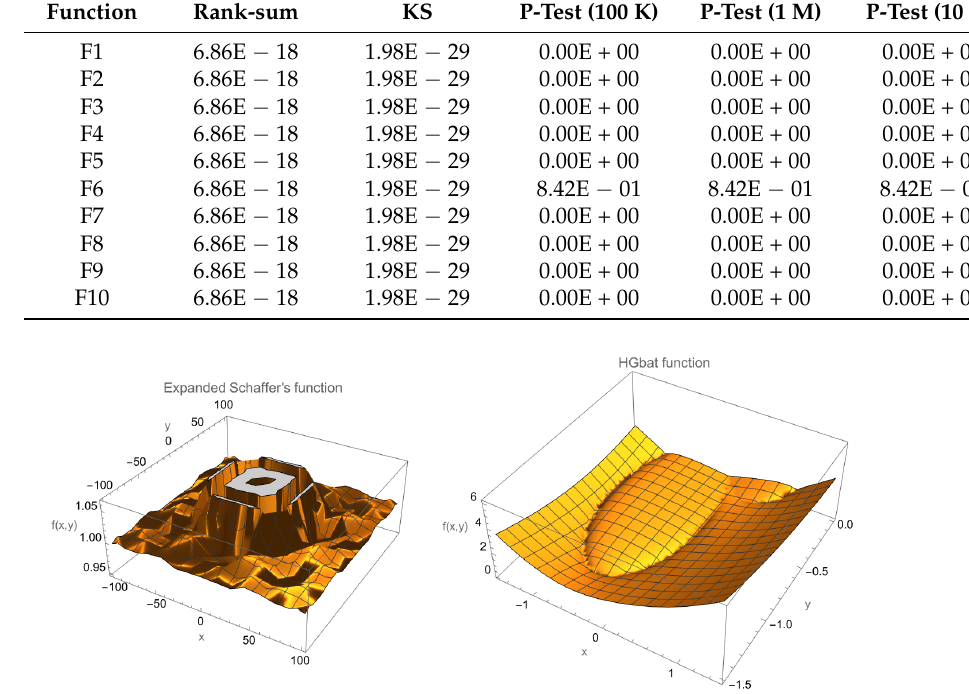
Figure 5. The landscapes of the Expanded Schaffer ( left ) and HGbat ( right ) functions.